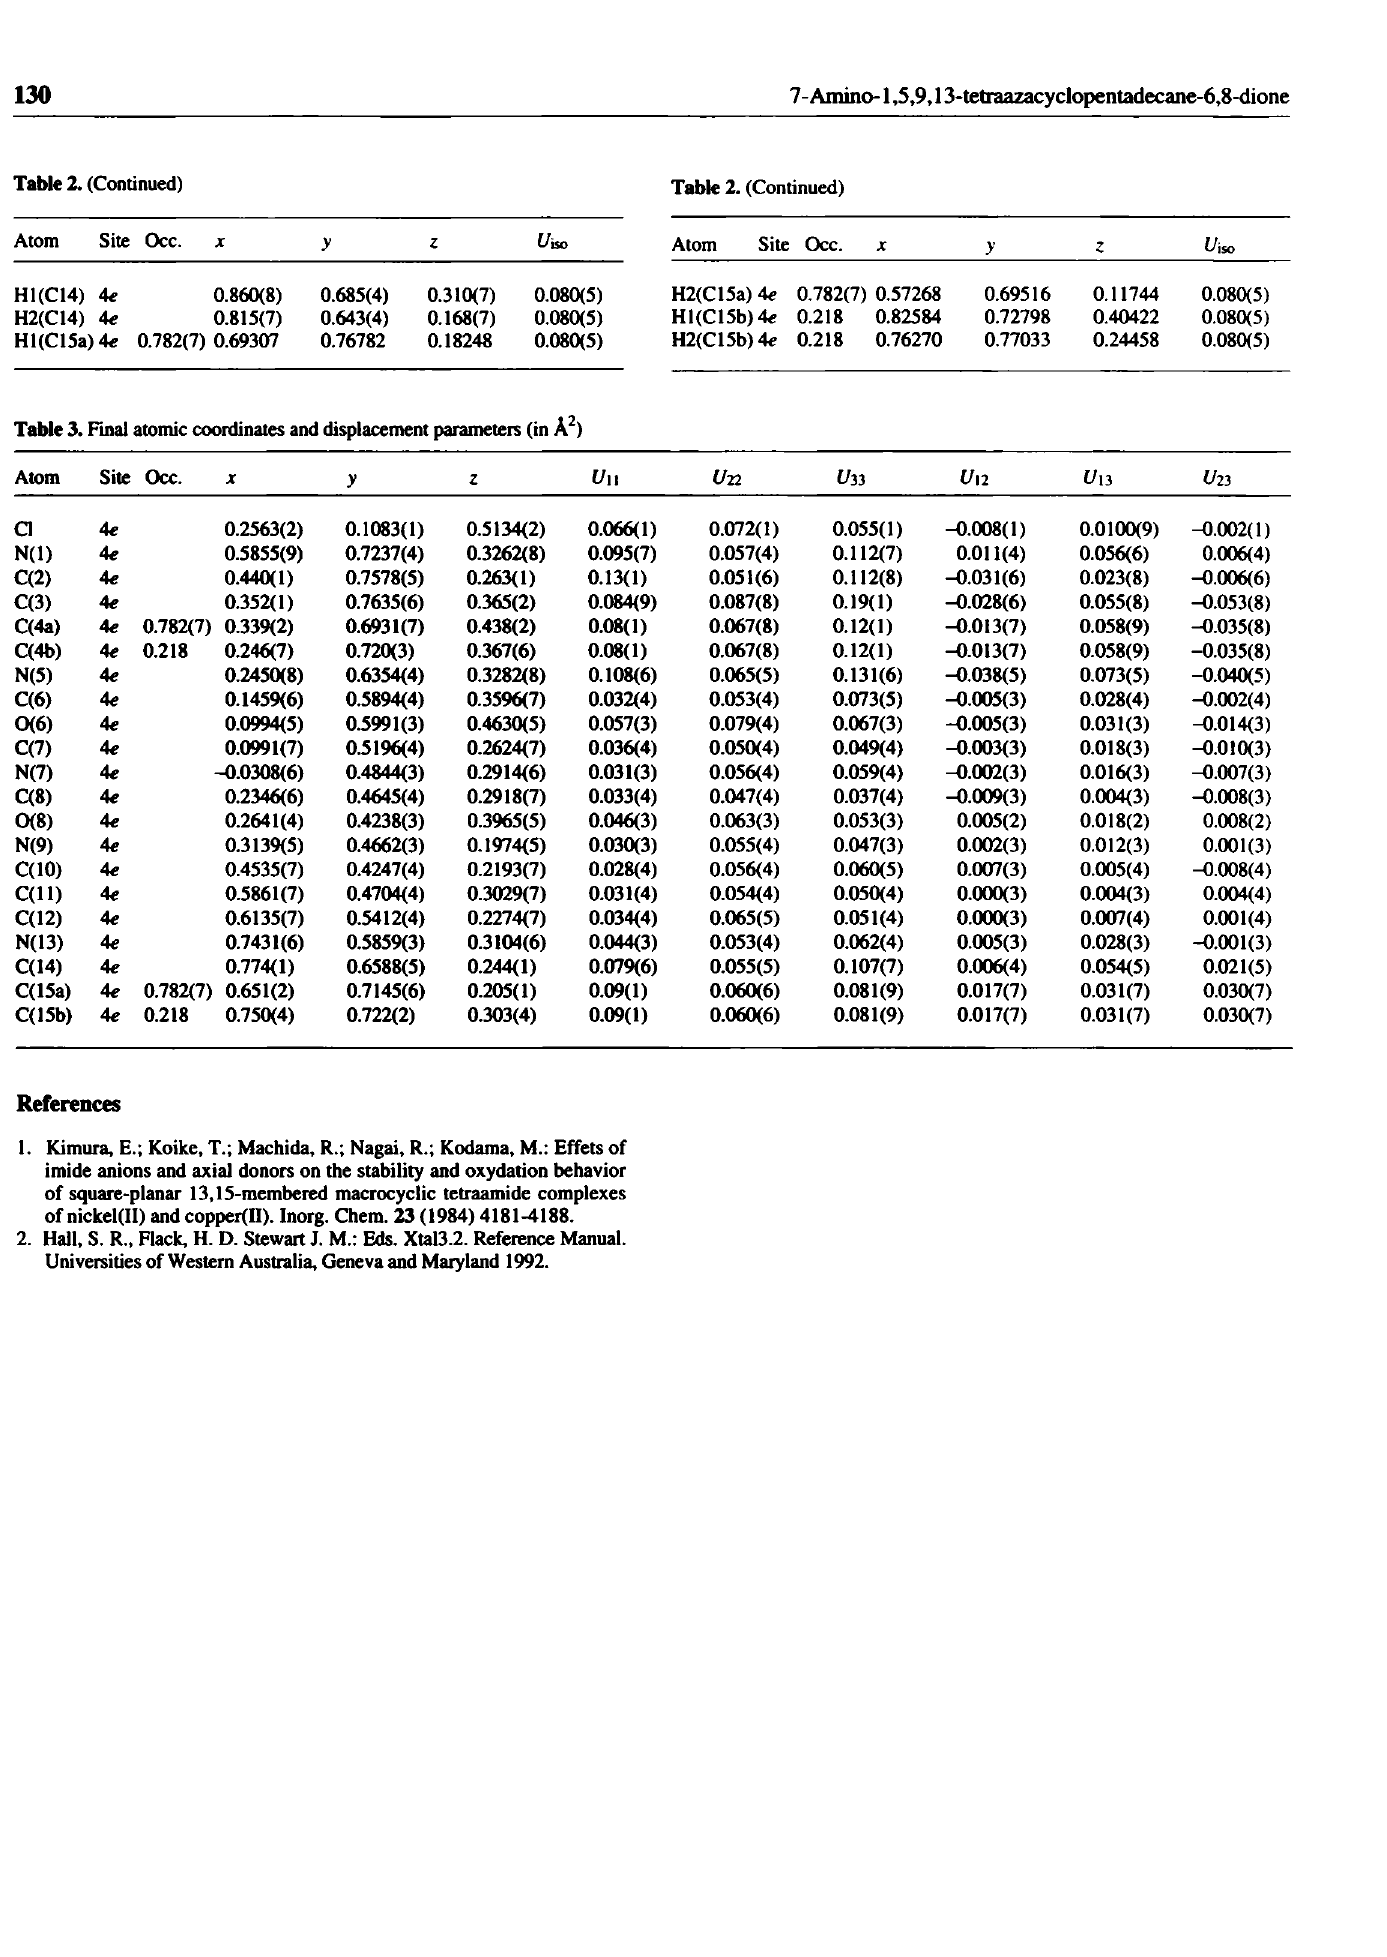
Table 3. Final atomic coordinates and displacement parameters (in Â 2